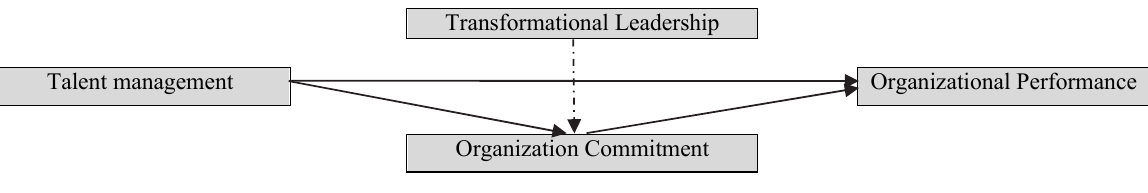
Fig. 1. Research conceptual